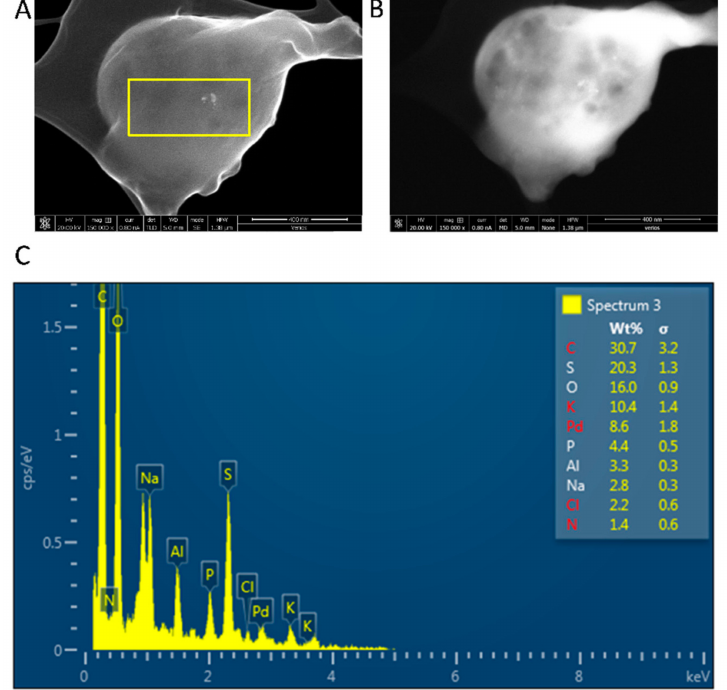
Figure 5. SEM-EDS analysis of PdCl 2 (TPPTS) 2 supported on i : ( A ) secondary electron imaging; ( B ) backscattered electron imaging; ( C ) EDS spectrum and tabulated results of EDS. The yellow rectangle in the inset image in Figure 5A shows the selected EDS inspection